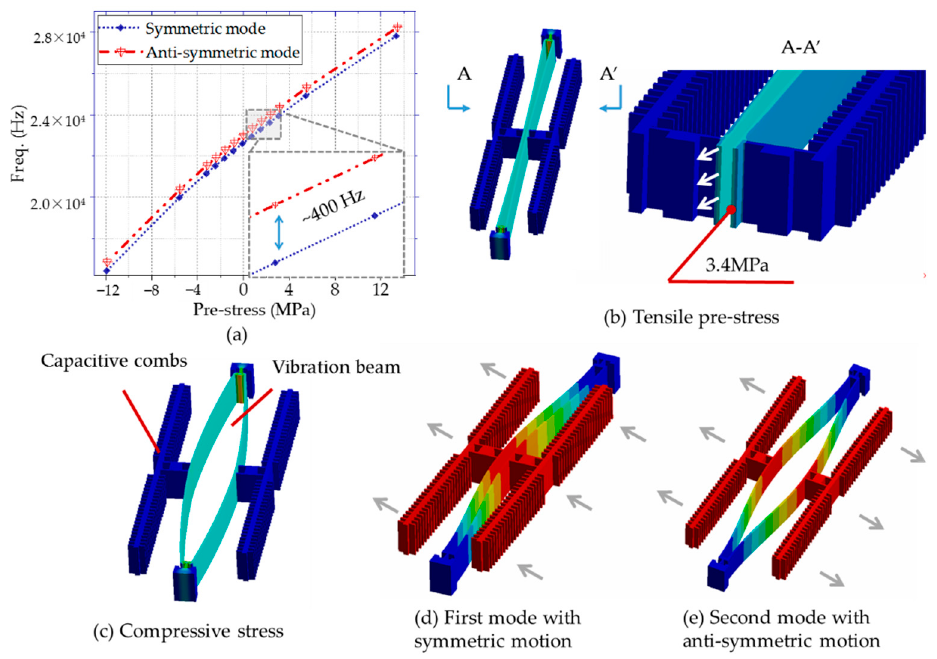
Figure 3. ( a ) The relationship between pre–stress and resonate frequencies; ( b ) Strain and stress distributions on the cross–section of the resonant beam under tensile stress; ( c ) Strain and stress under compressive stress; ( d , e ) Symmetric and antisymmetric motion of resonance